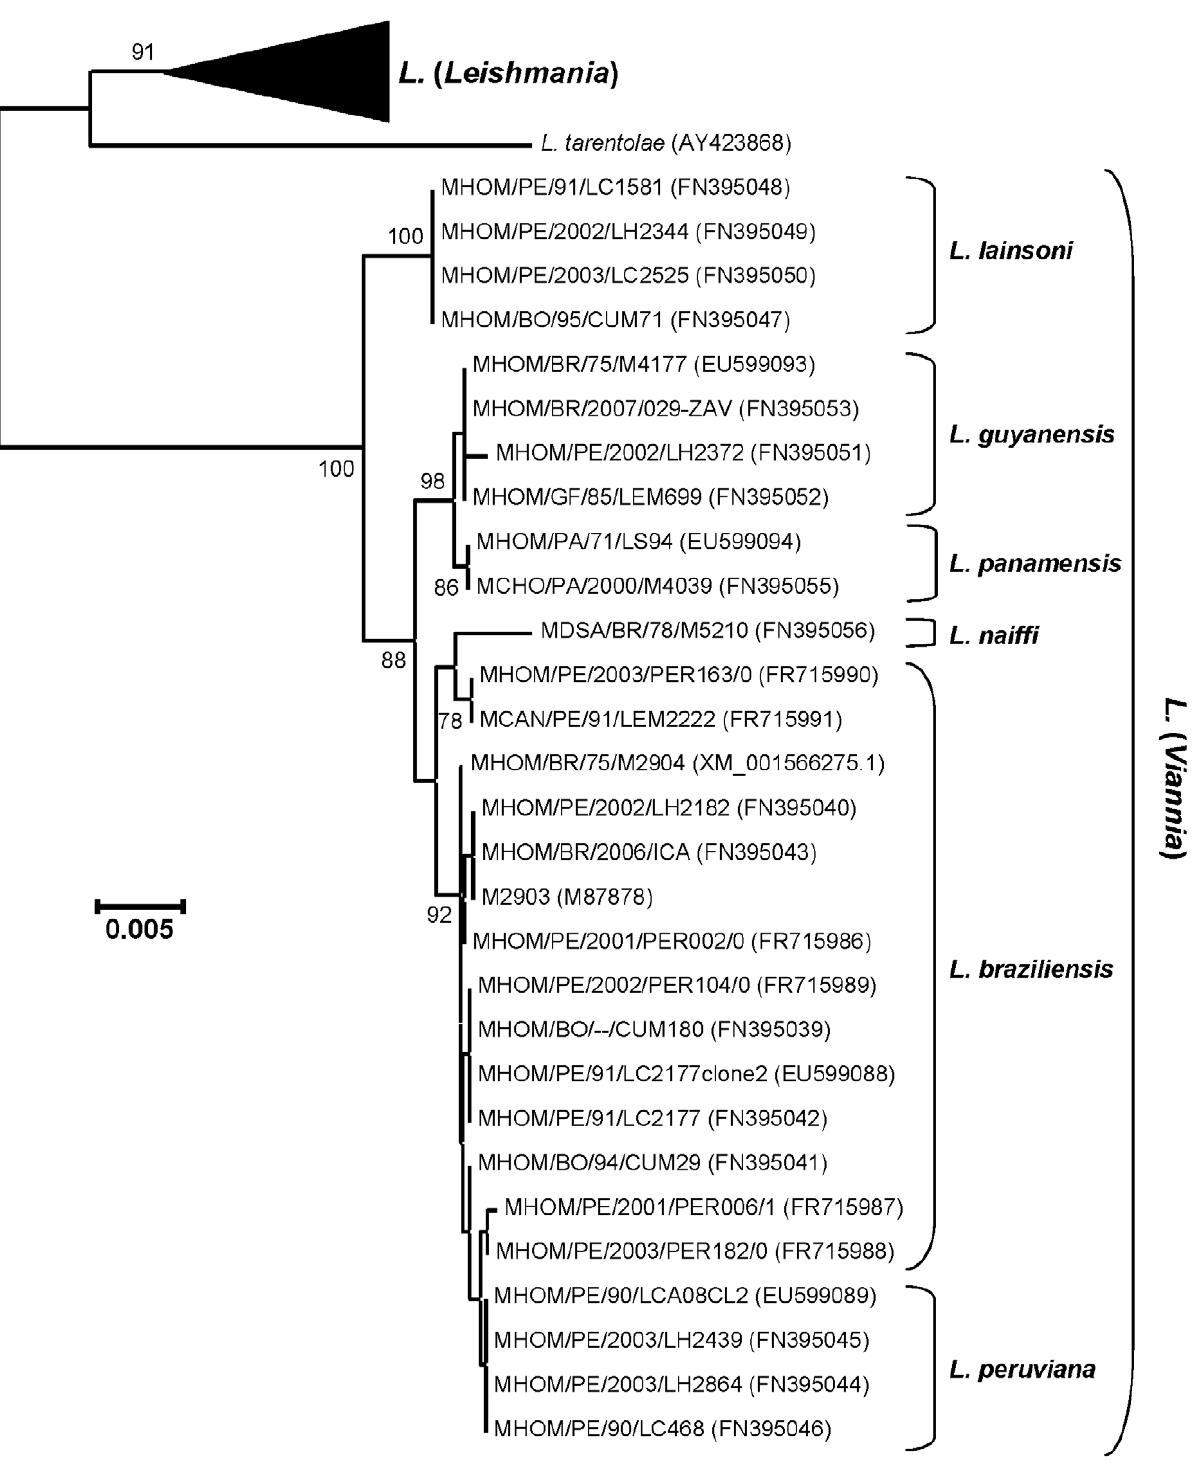
Figure 1. Neighbor-Joining dendrogram based on p-distances of the hsp 70 sequences determined in this study, aligned with those from Fraga etal. [ 9 ] as a reference set. The total alignment contains 1380 nucleotides. Bootstrap support of the branches was inferred from 2000 replicates, and is shown in percentages at the internodes when exceeding 70%. The tree is drawn according to the scale on the left, expressed as distance per nucleotide. Different species are depicted on the right, whereby species of the L. ( Leishmania ) subgenus are condensed. The tree was rooted on the branch leading to L. ( Viannia ). Isolates are indicated with their WHO code wherever possible, with accession numbers between brackets. Accessions starting with XM are derived from a contemporary annotation of full genome sequences, and are GenBank specific.